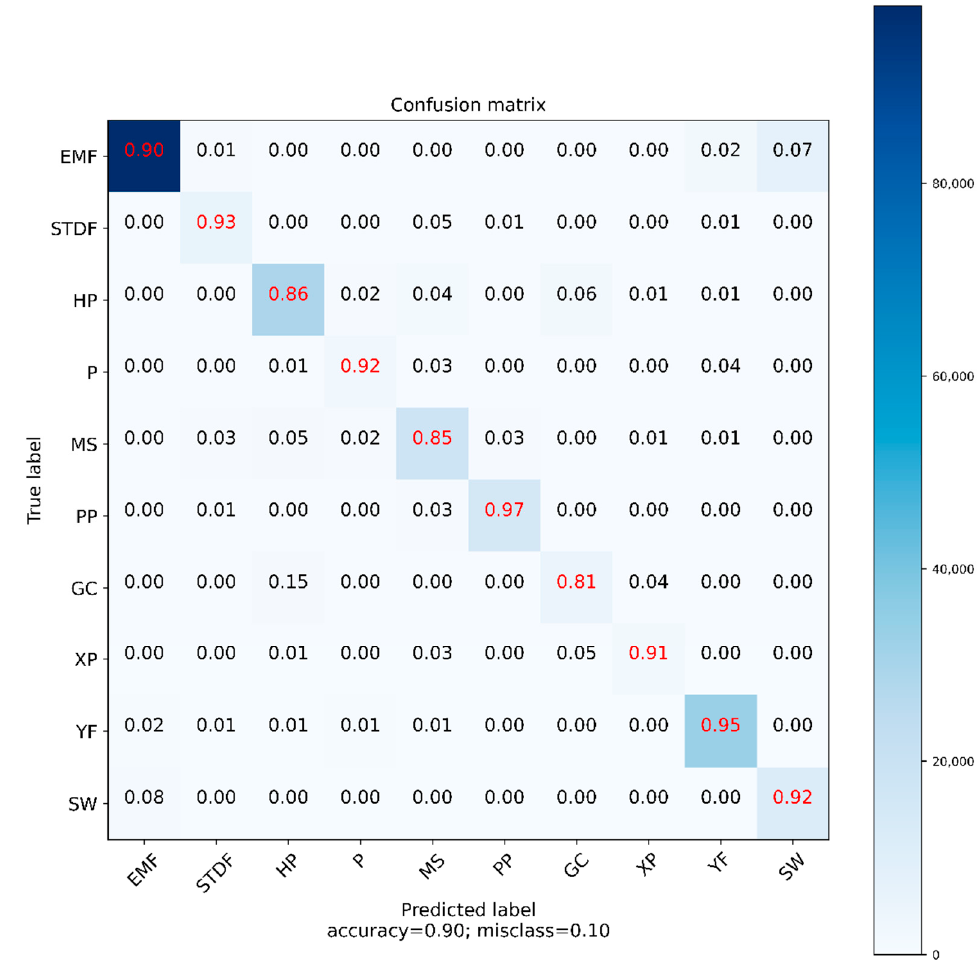
Figure A2. Dispersion of efficiency indicators of the cross validations for each bioclimatic model using the raining data (80% of the present biome map).